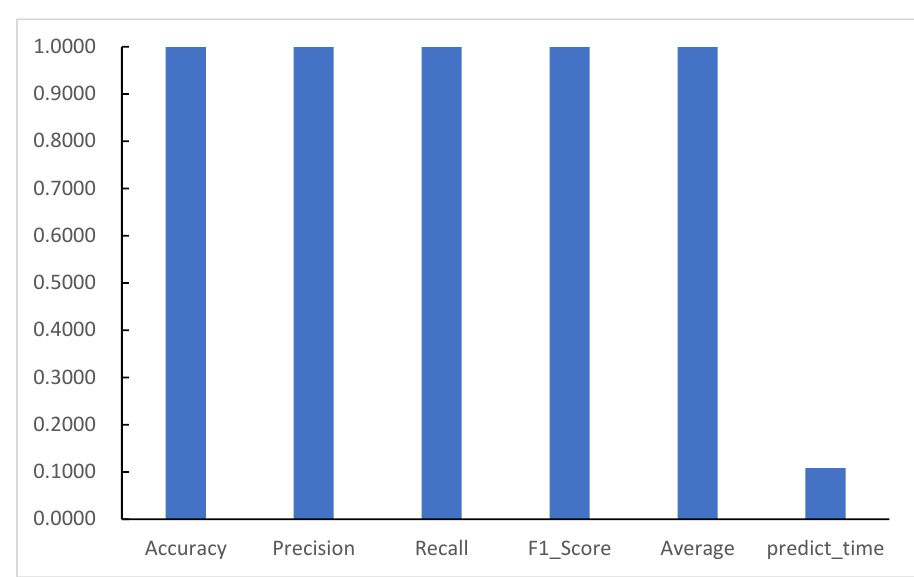
Figure 19. RF optimized performance metrics chart.